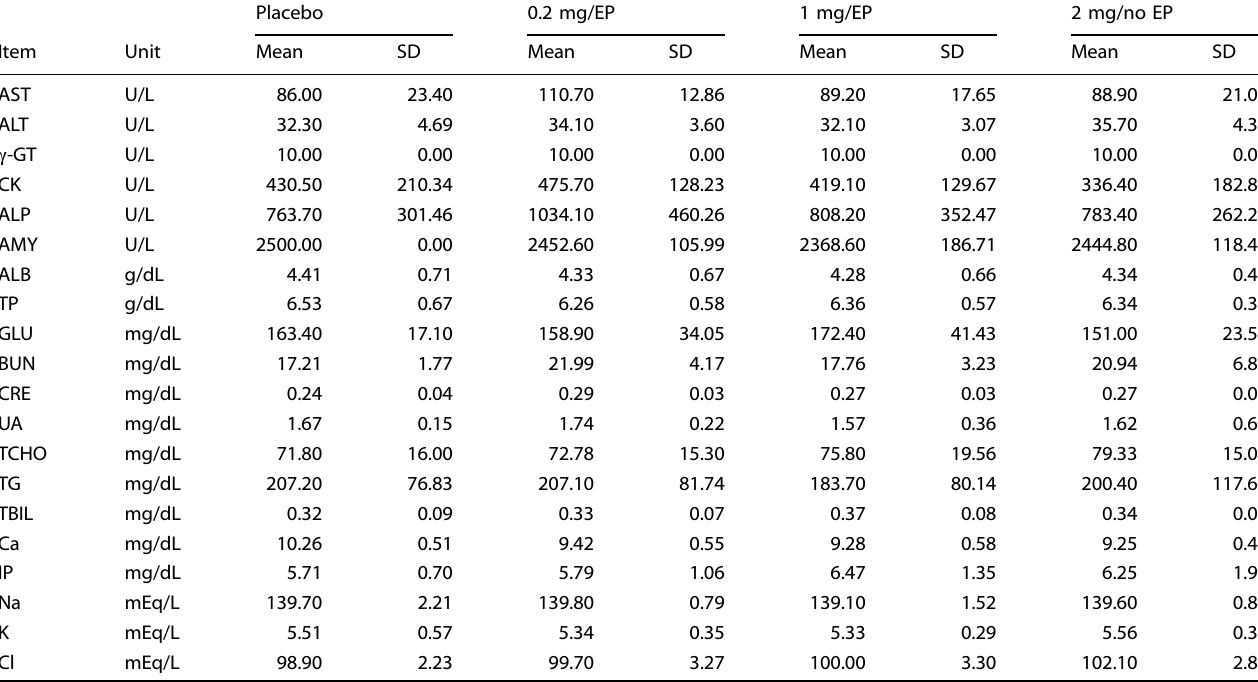
Table 3. Effect of DNA vaccination on blood biochemistry in a repeated-dose toxicity study.